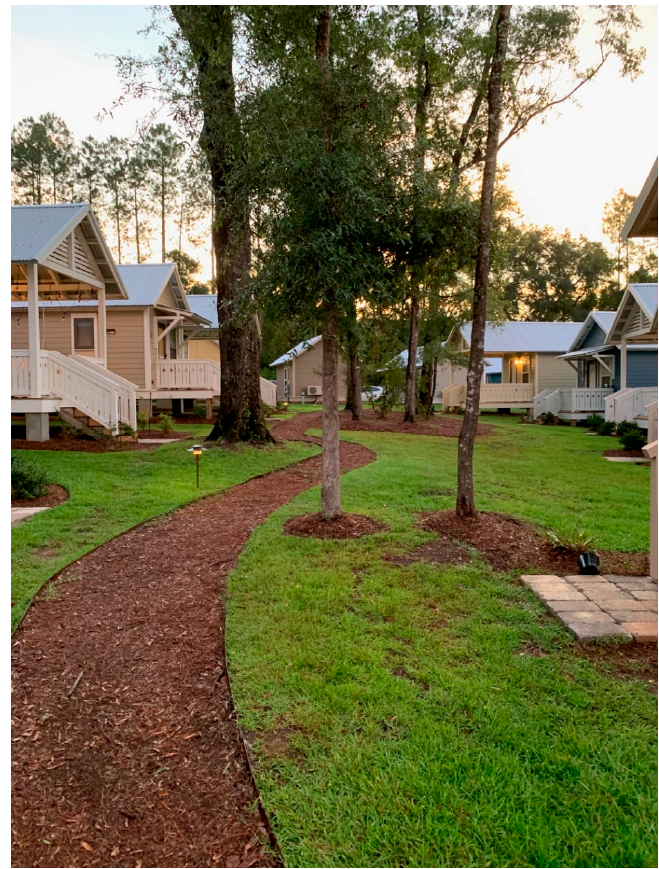
Figure 5. The Dwellings greenway.